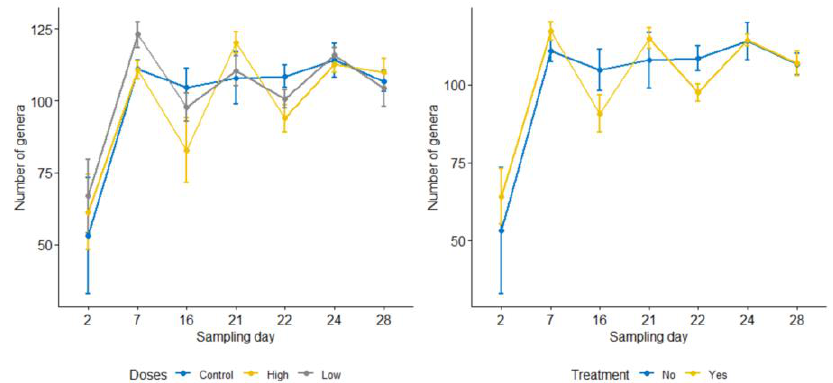
Figure 5. Comparisons of bacterial genus counts by sampling days among control, low dose, and high dose groups ( left ) and between the control and the combined treatment groups ( right ). The differences between groups on each sampling day were not significant for both comparisons ( p > 0.05).